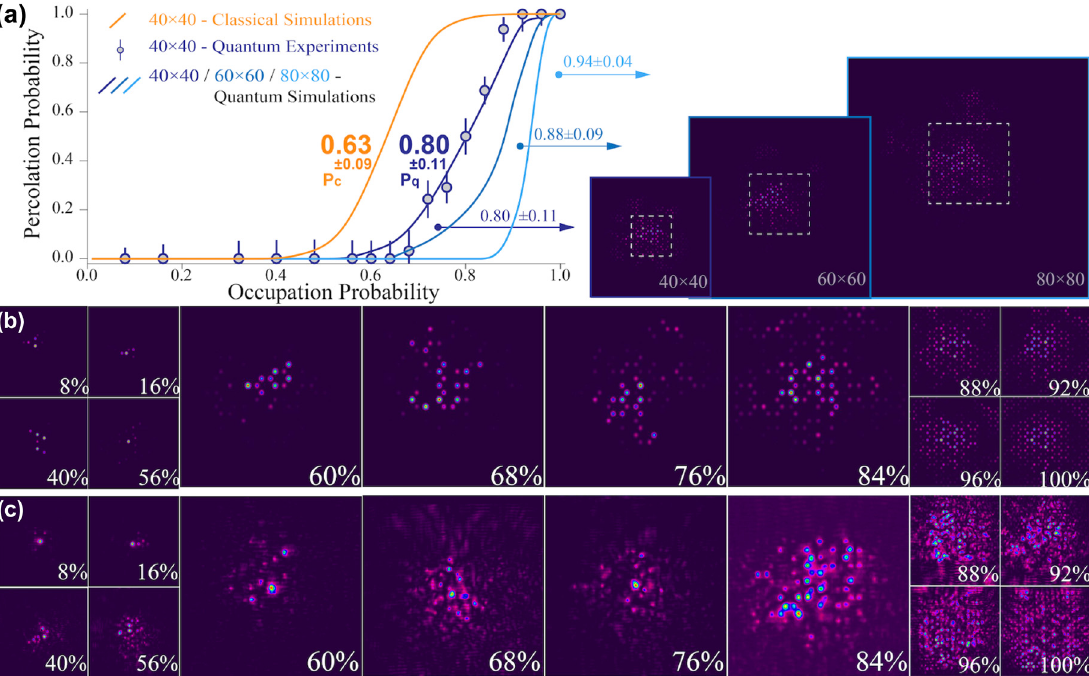
Figure 4: Experimental observation of a transition in quantum percolation. (a) Experimental and theoretical results both demonstrate a sharp quantum percolation transition in the occupation probability range of 80 ± 11 % , i.e. from 69 to 91 % . Error bars are obtained by error transfer function, see derivation in Supplementary Section 4. With the increase of lattice size, the transition turns sharp and the threshold shifts to the right. The cross sections in each scale are attached. Transverse sections for different occupation probabilities are shown in (b) simulations and (c)